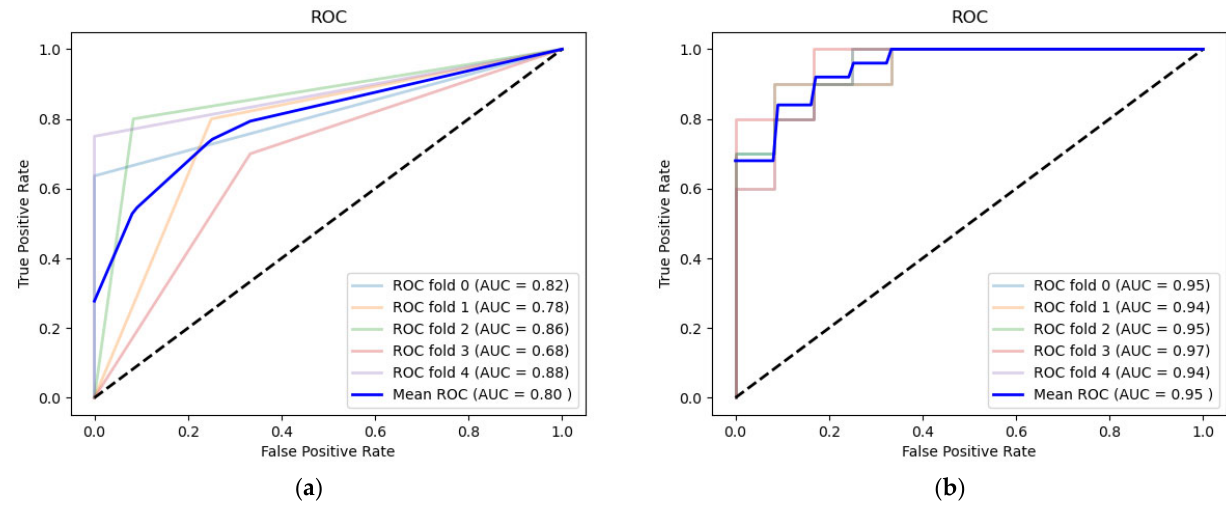
Figure 7. ROC curve of SVM: ( a ) non ‐ feature selection; ( b ) IG.